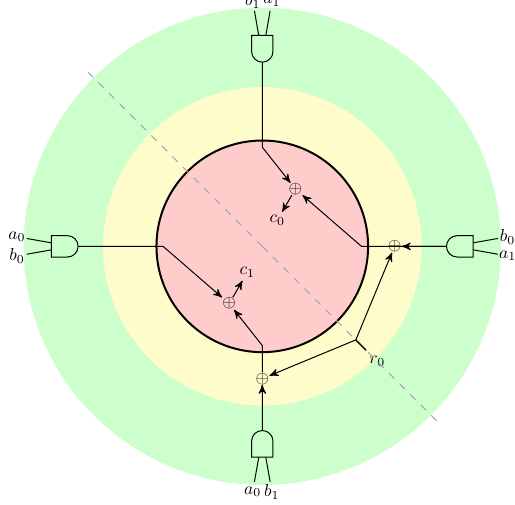
Figure 16: The DOM scheme for d = 1 , s =